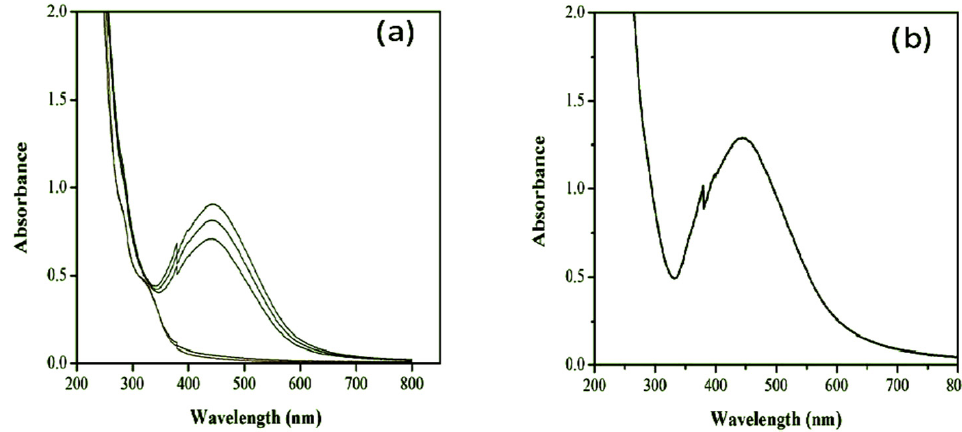
Figure 1. UV-Vis spectra of reaction at room temperature A h ( a ), and under ultrasonication A